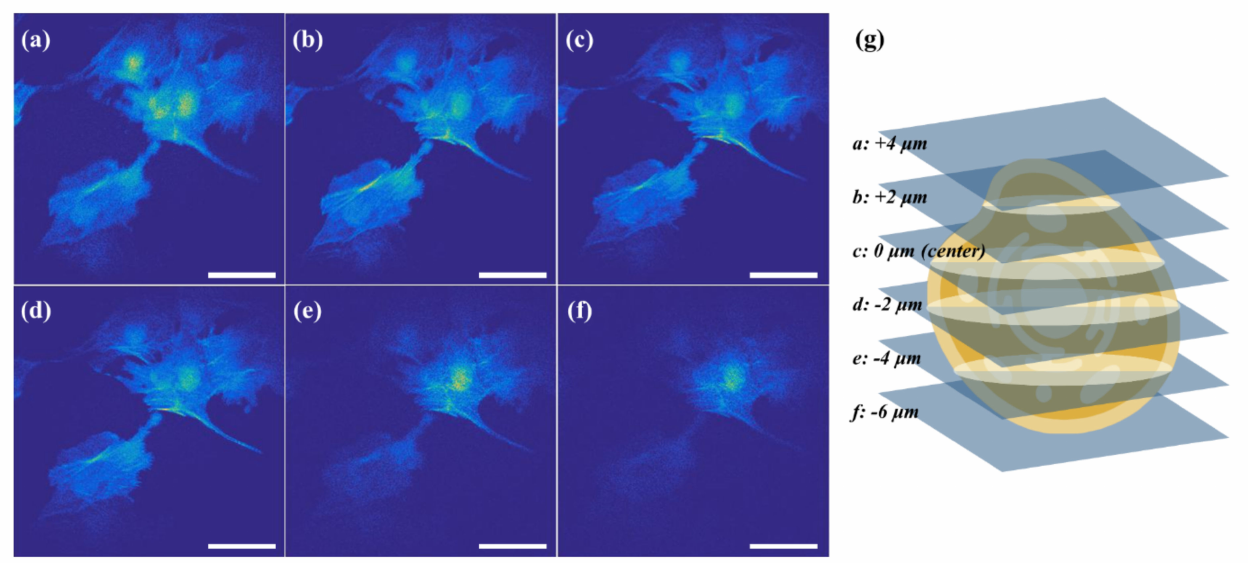
Figure 9. The images for the stained bovine pulmonary artery endothelial (BPAE) cells at different depths from the center: ( a ) +4 µ m; ( b ) +2 µ m; ( c ) 0 µ m; ( d ) − 2 µ m; ( e ) − 4 µ m; and ( f ) − 6 µ m (scale bar: 10 µ m). ( g ) Illustration of the 3D image of BPAE